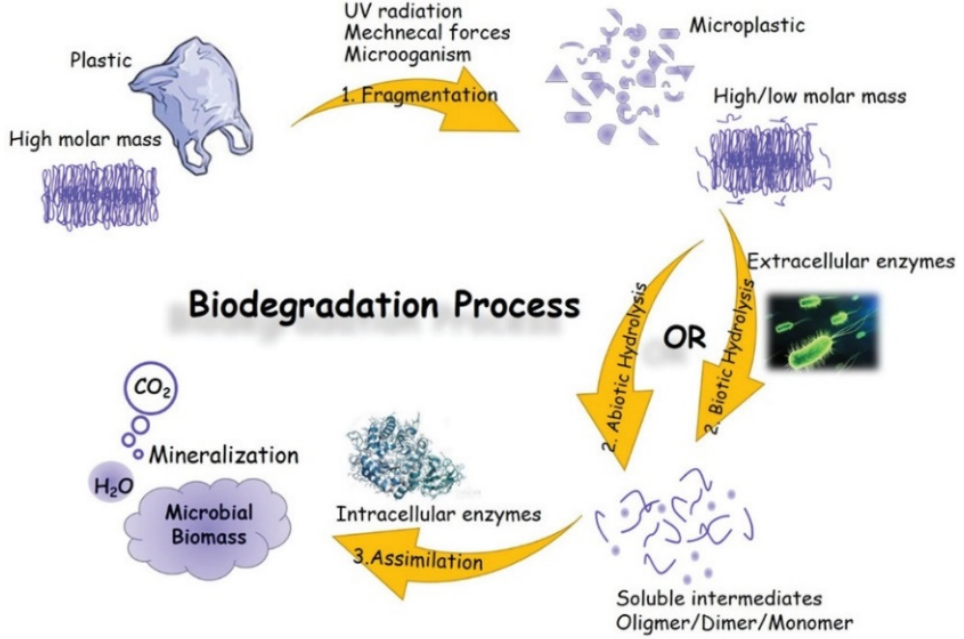
Figure 10. The different steps are involved in the biodegradation process [18].